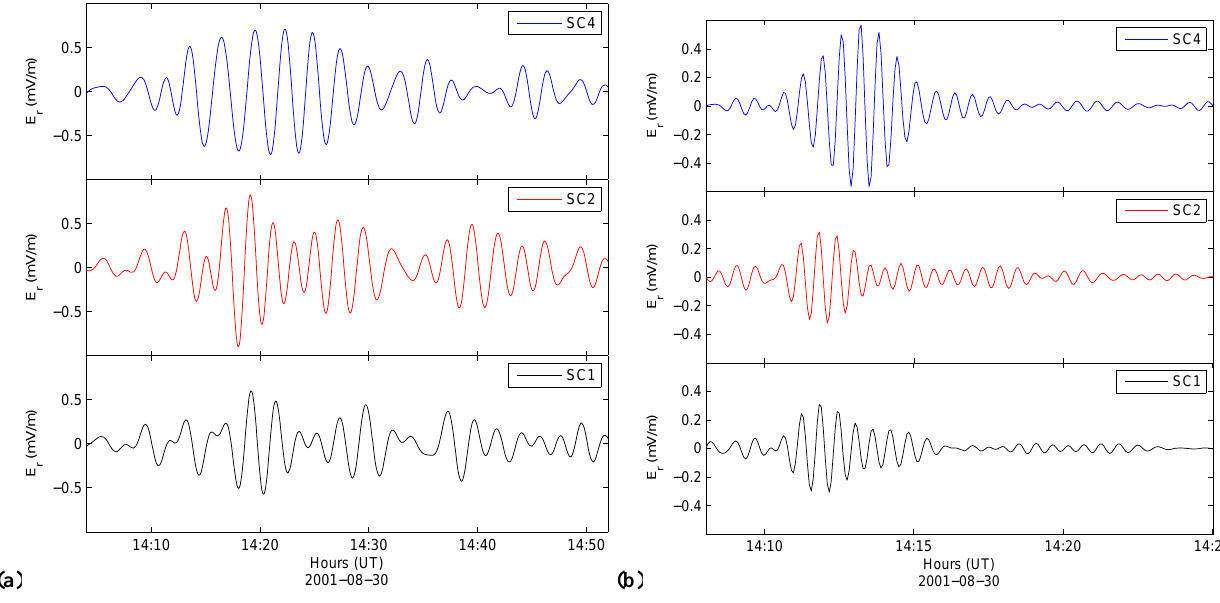
Fig. 10. The radial component of the electric field for SC 1 (black), SC 2 (red) and SC 4 (blue) for the (a) 6.8mHz wave (b) 27mHz wave.